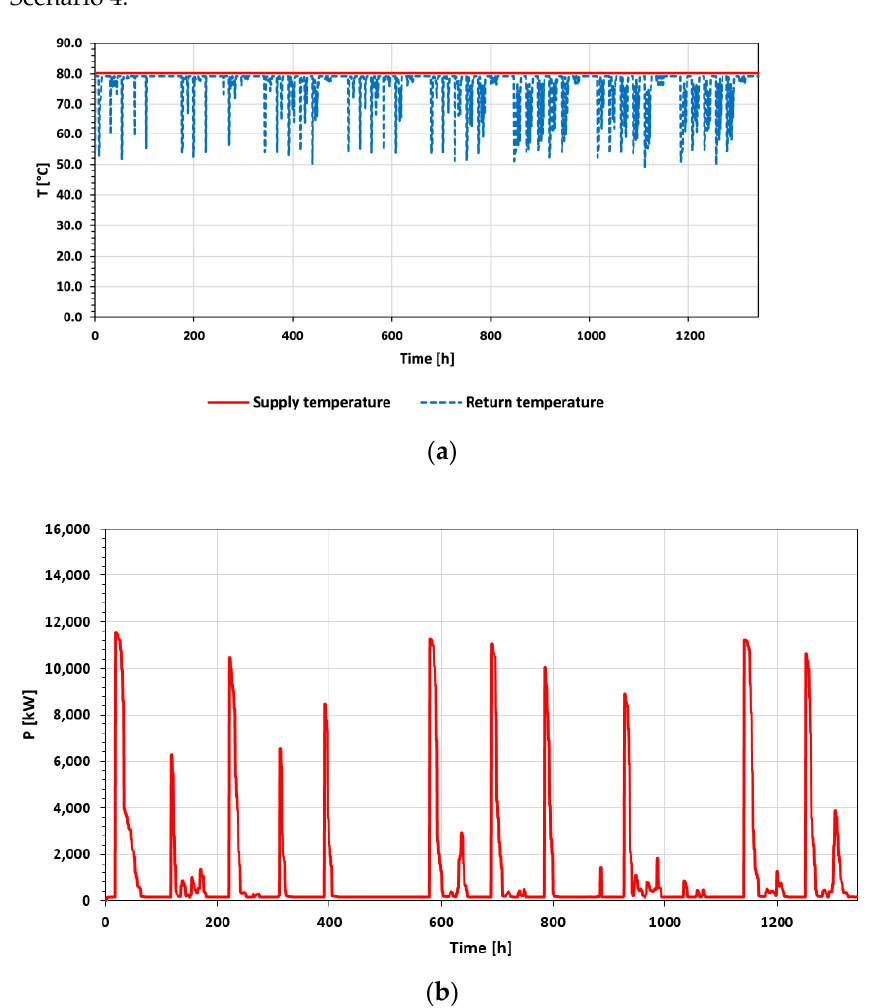
Figure 8. Scenario 1 — Central heating system along the simulation time [h]: ( a ) supply (red) and return (blue) temperatures [ ◦ C], ( b ) power supplied to the network [kW].